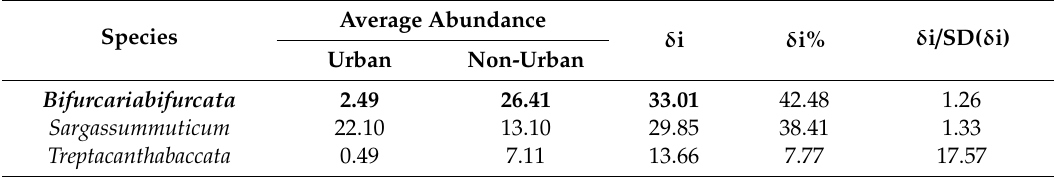
Table 3. Contribution ( δ i ) of individual canopy species to the average Bray-Curtis dissimilarity between urban and non-urban shores.